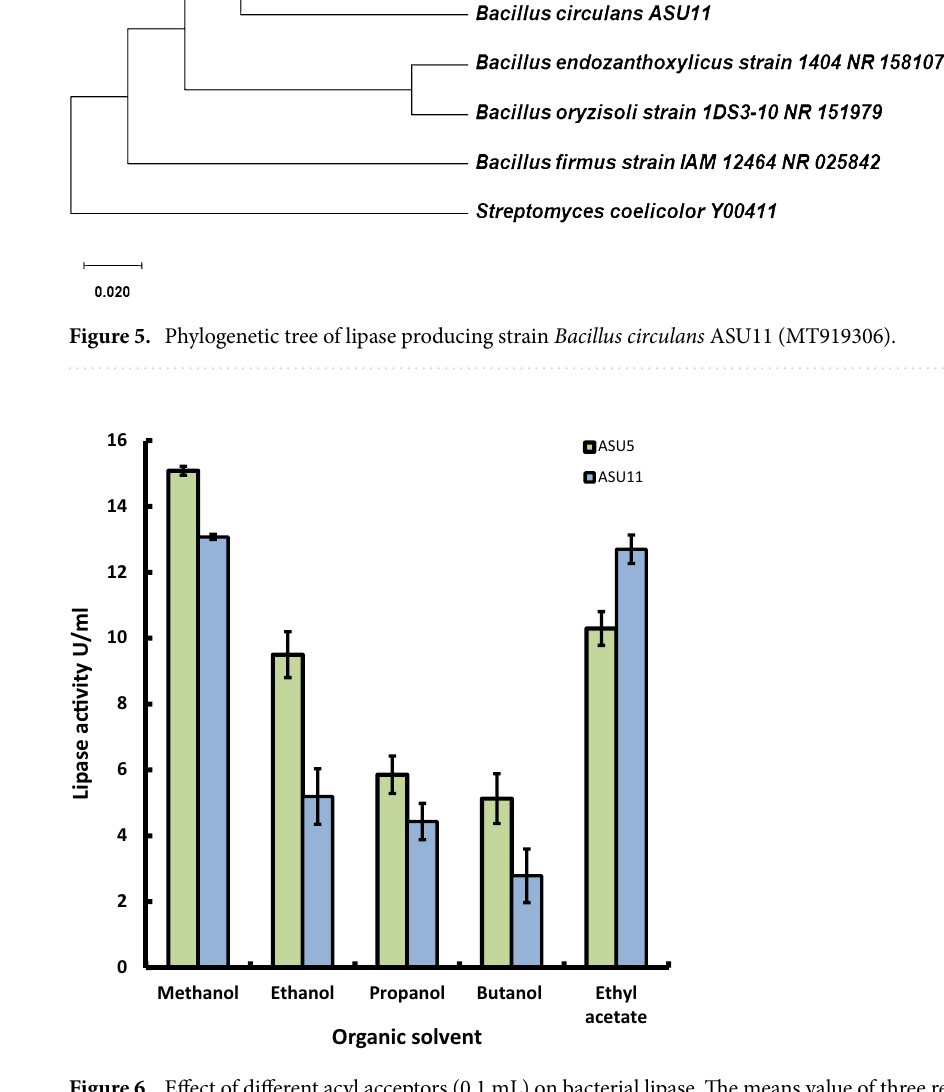
Figure 6. Effect of different acyl acceptors (0.1 mL) on bacterial lipase. The means value of three replicates ± SD (vertical bars) is